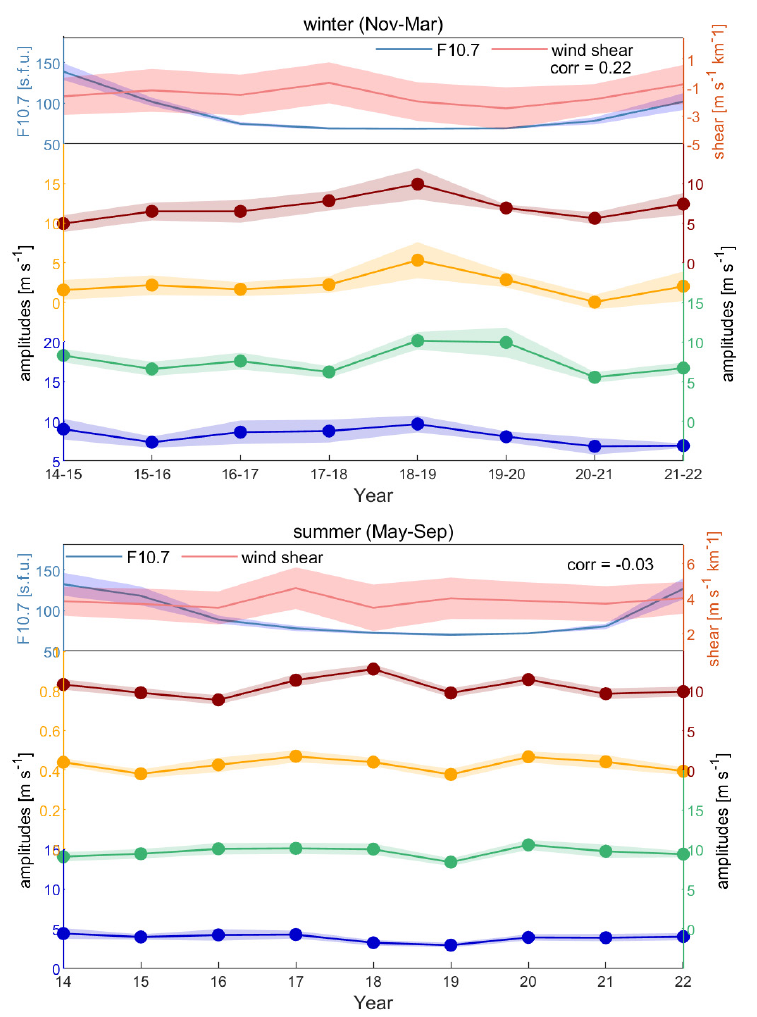
Figure 12. Top panel : Seasonal mean Q16DW total amplitudes for winter (November–March, top panel) for different altitudes in blue (78 km), green (84 km), orange (90 km), and red (96 km) lines and dots. The shadings denote the standard deviation of each season. The light blue line and shading indicate the seasonal mean of the F10.7 index (sfu) and their standard deviations, while the light red line and shading indicate the seasonal mean of zonal wind shear at 84 km and the standard deviation (m s − 1 ). Bottom panel : the same as the top panel except for summer (May–September). In the summer (bottom panel of Figure 12), the amplitudes are not always as homogeneous among different altitudes, except for the minimum at all altitudes during the summer of 2019. The correlation with wind shear is also insignificant at all altitudes, with correlations ranging from − 0.2 to 0.2.